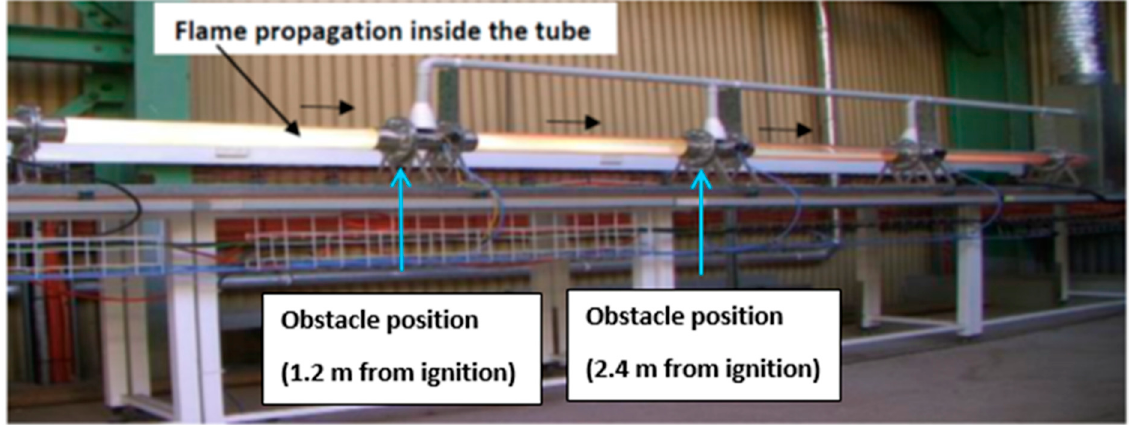
Figure 2. Illustration of fl ame propagation inside the tube.